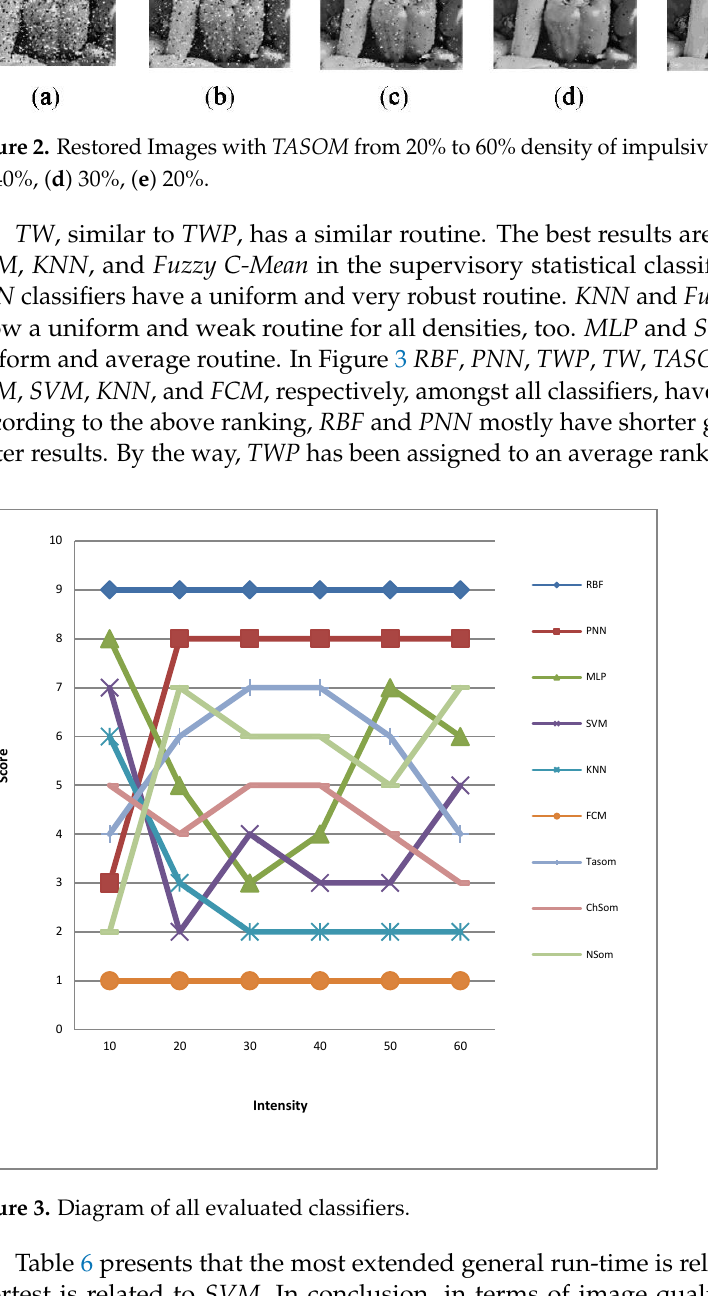
Figure 3 . Diagram of all evaluated classifiers Figure 3. Diagram of all evaluated